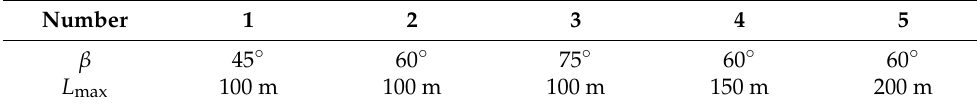
Table 3. Parameters for searching target-aided points.